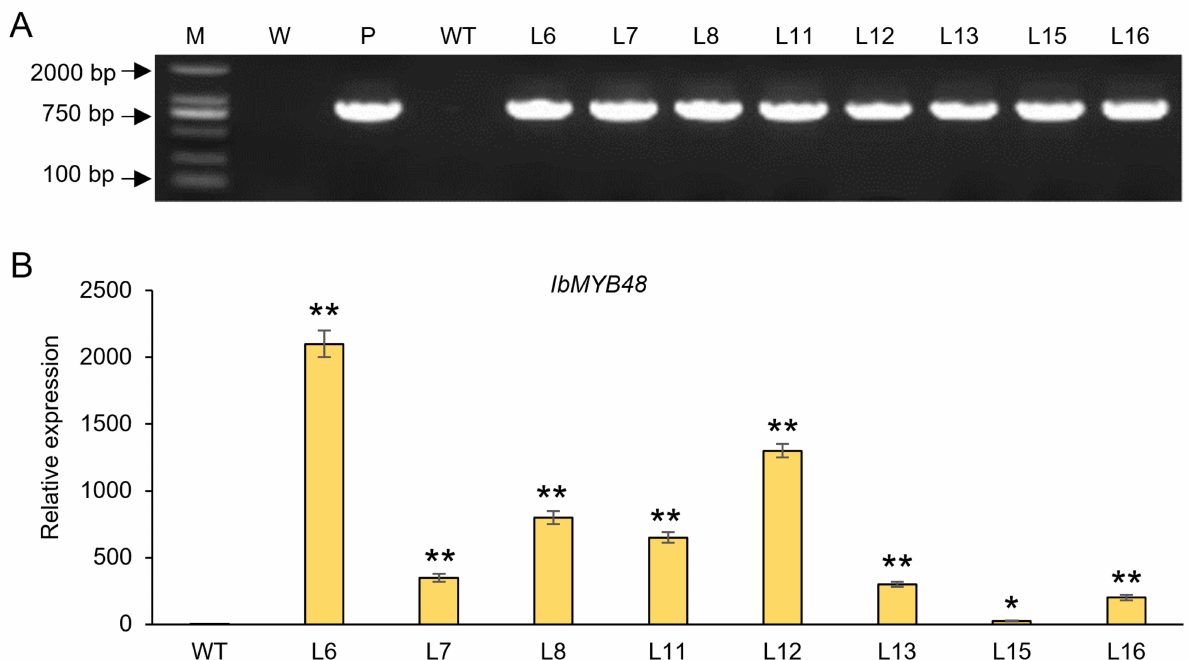
Figure 5. Identification of IbMYB48 -overexpression transgenic plants. ( A ) Identification of transgenic lines by PCR. M, DL2000 DNA maker; W, water as a negative control; P, plasmid